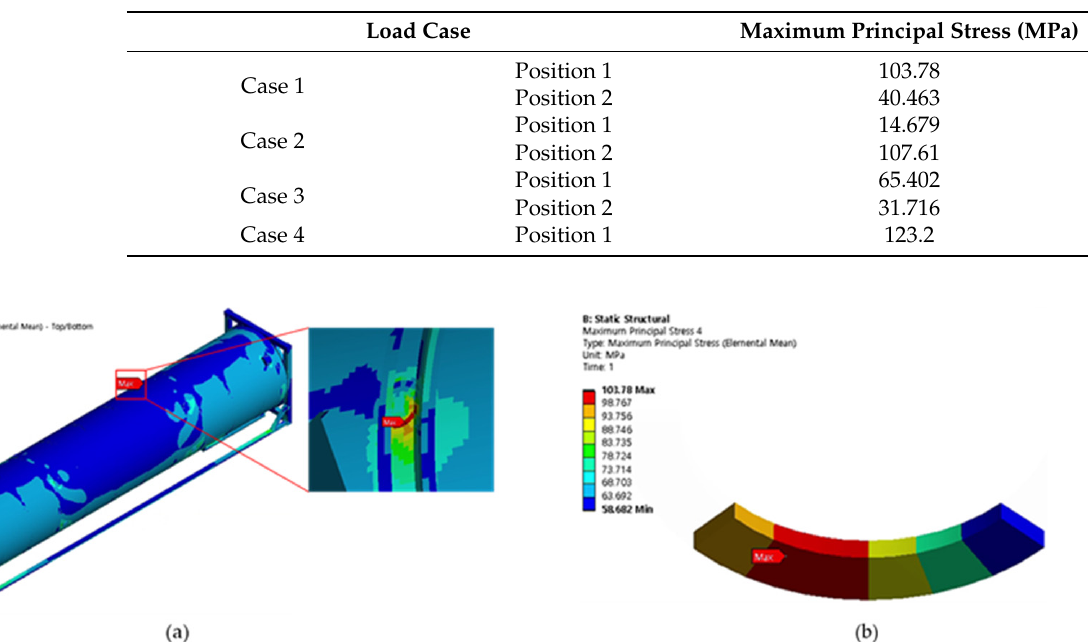
Table 3. Maximum principal stress.